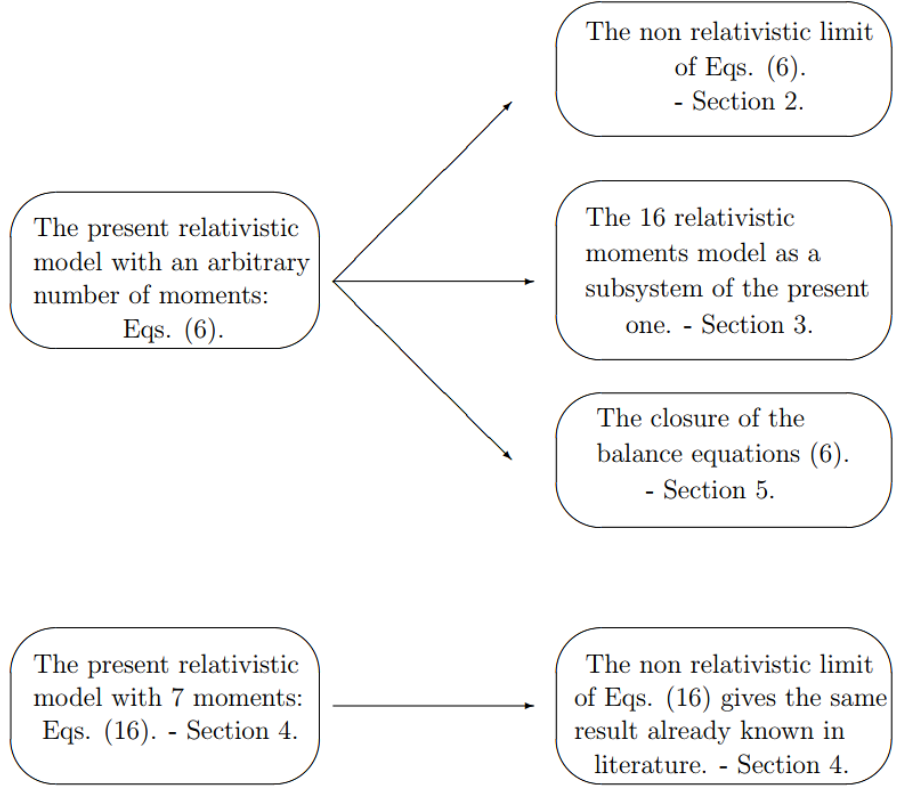
Figure 1. Flowchart of the research